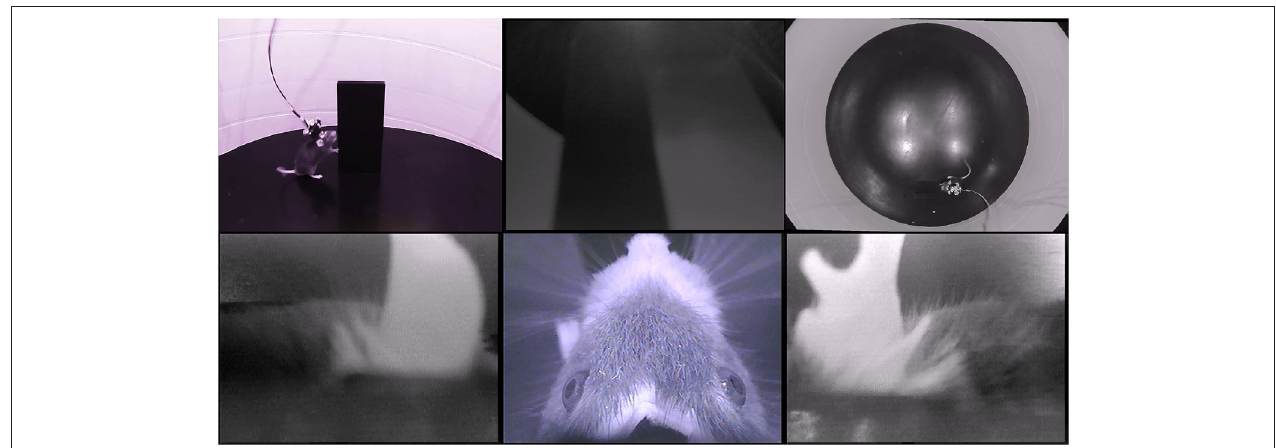
FIGURE 1 | Example data from the four-camera headset. An example frame from Supplementary Video 1 , showing the webcam views of a mouse exploring an open arena, from the side (top left) and above (top right), and the video signals from the four-camera headstage-integrated headset: left ear camera (bottom left), right ear camera (bottom right), overhead camera (bottom middle), and forward-facing camera (top middle). Note that the overhead camera video signal is of higher quality than the front-facing or ear-facing videos, due to their filtering.